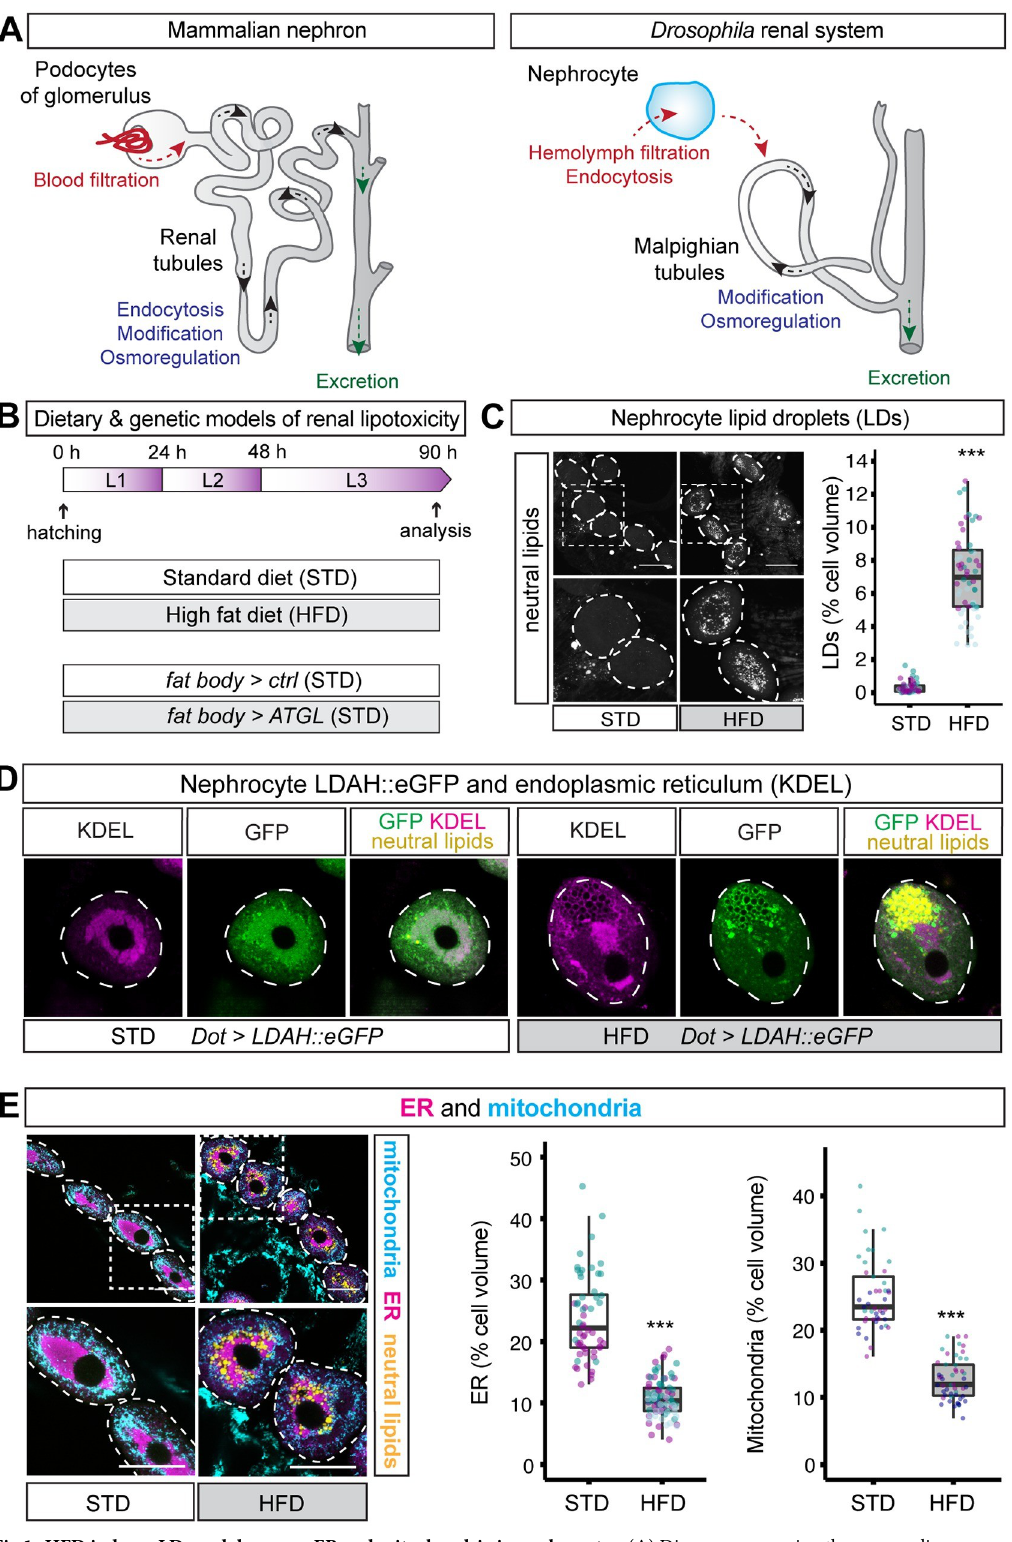
Fig 1. HFD induces LDs and decreases ER and mitochondria in nephrocytes. ( A ) Diagram comparing the mammalian nephron and the Drosophila renal system. Drosophila nephrocytes share functions with mammalian podocytes of the